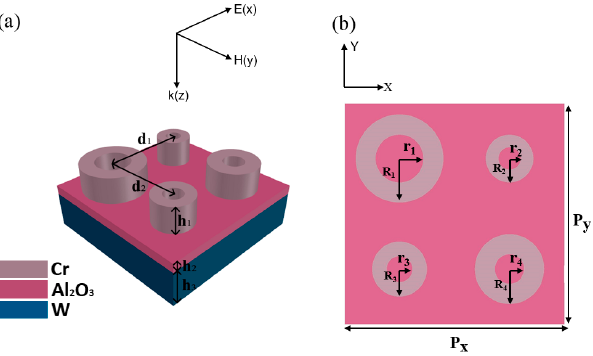
Figure 1. ( a ) Structure diagram of one unit of absorber; ( b ) Top view of unit structure.